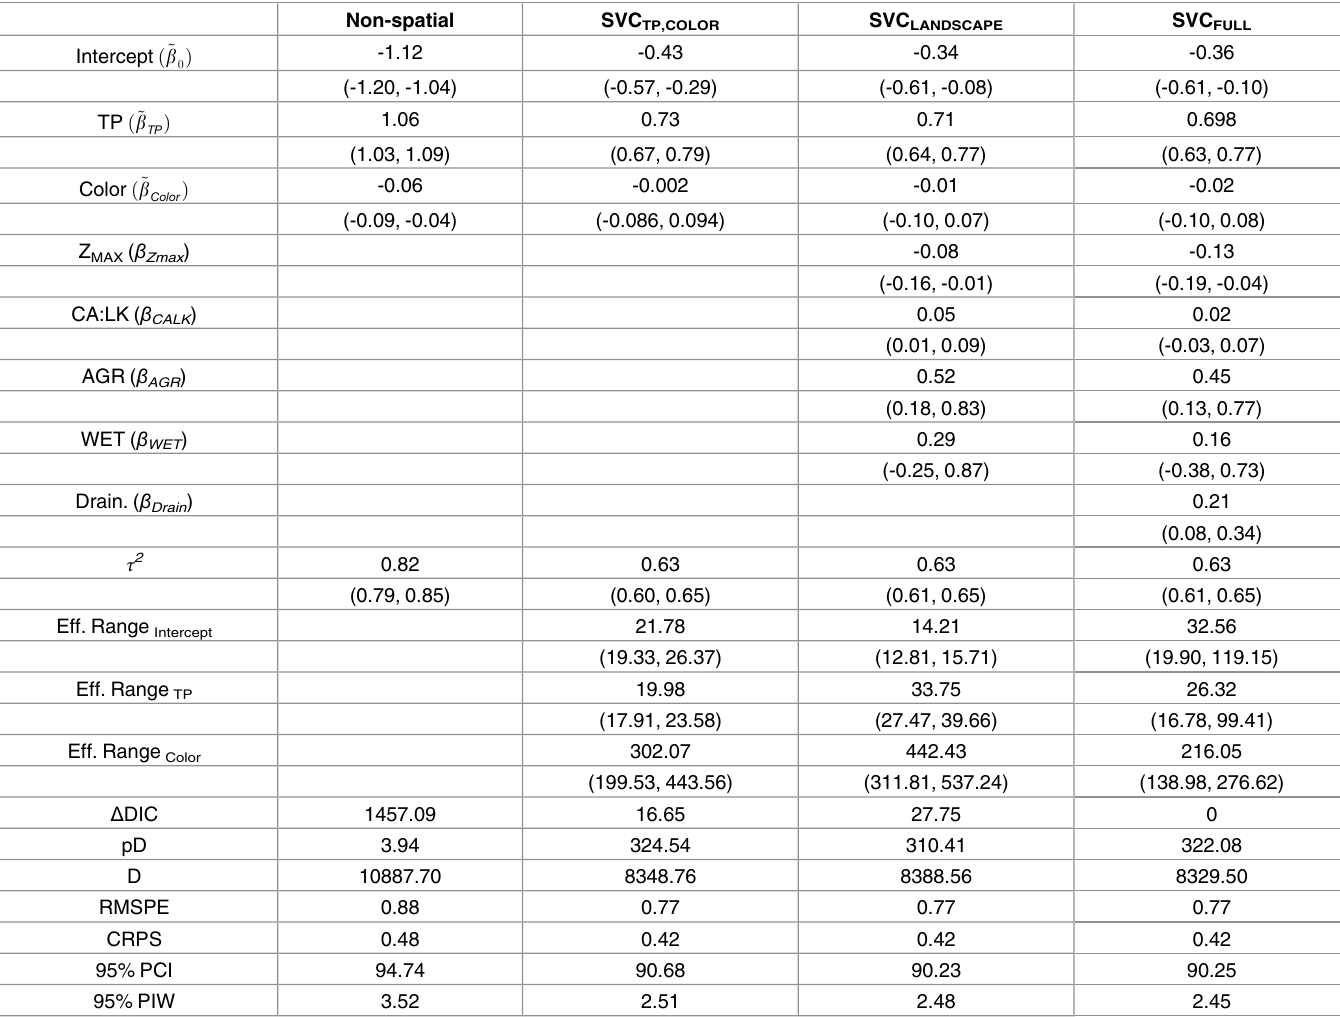
Table 2. Summary of TP and water color ~ CHL candidate models including posterior estimated coefficients, model fit criteria, and model predic- tive performance measures. Non-spatial SVC